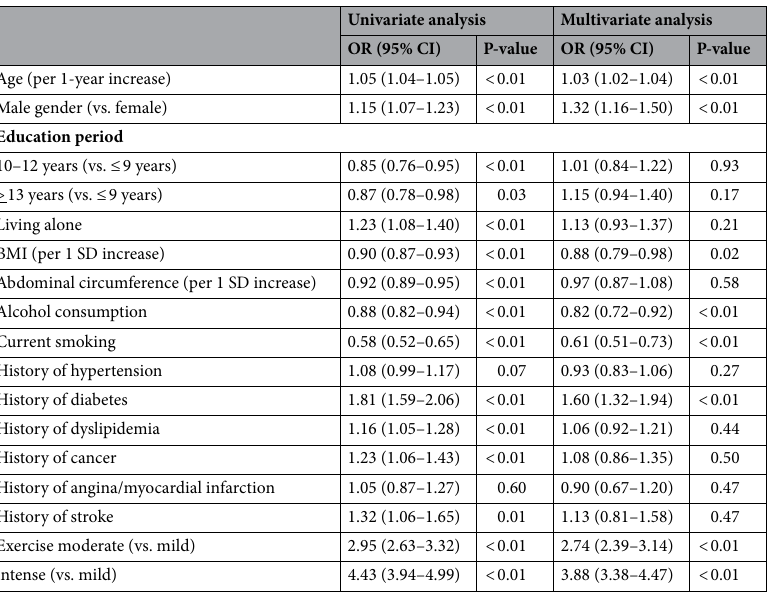
Table 3. Factors associated with action vs. intention: logistic regression analysis. OR odds ratio, CI confidence interval, BMI body mass index, SD standard